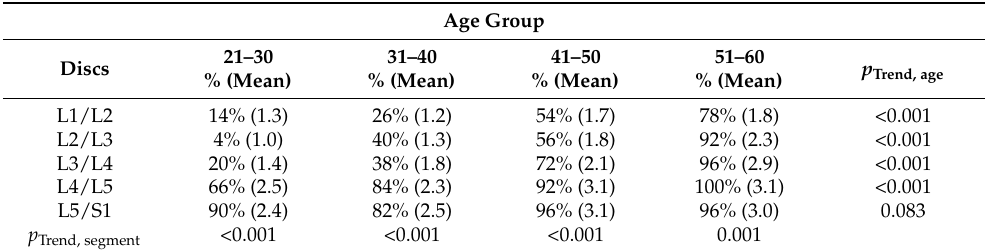
Table 5. Proportion of segments affected by degenerative processes, taking into account the individual segments and age of the subject with the average number of positive individual criteria for segment degeneration where at least one characteristic is positive.